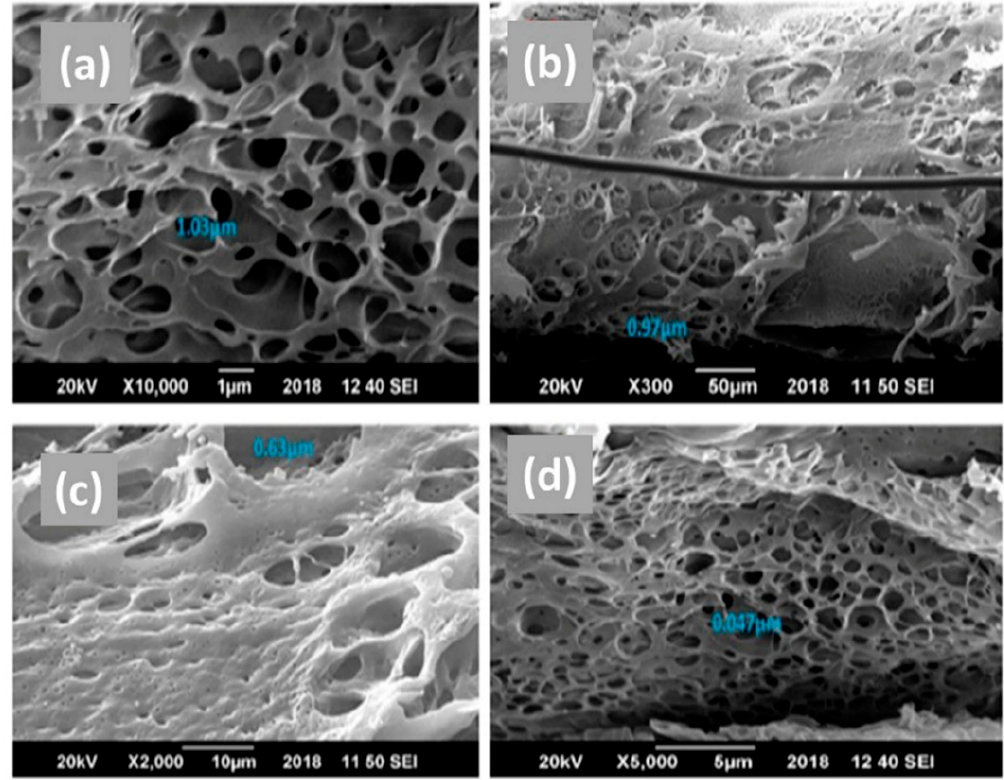
Figure 3. Scanning Electron Microscopy image showing morphology and pore size of the ( a ) pure polyethersulfone (PES), ( b ) cannabinoid embedded polyethersulfone (C-PES), ( c ) terpene embedded polyethersulfone (T-PES), and ( d ) cannabinoid and terpene embedded polyethersulfone (CT-PES), membranes. Table 1. Average width along with the average pore size of pure polyethersulfone (PES), terpene embedded polyethersulfone (T-PES), and cannabinoid embedded polyethersulfone (C-PES), cannabinoid and terpene embedded polyethersulfone (CT-PES) membranes. Sr. No.